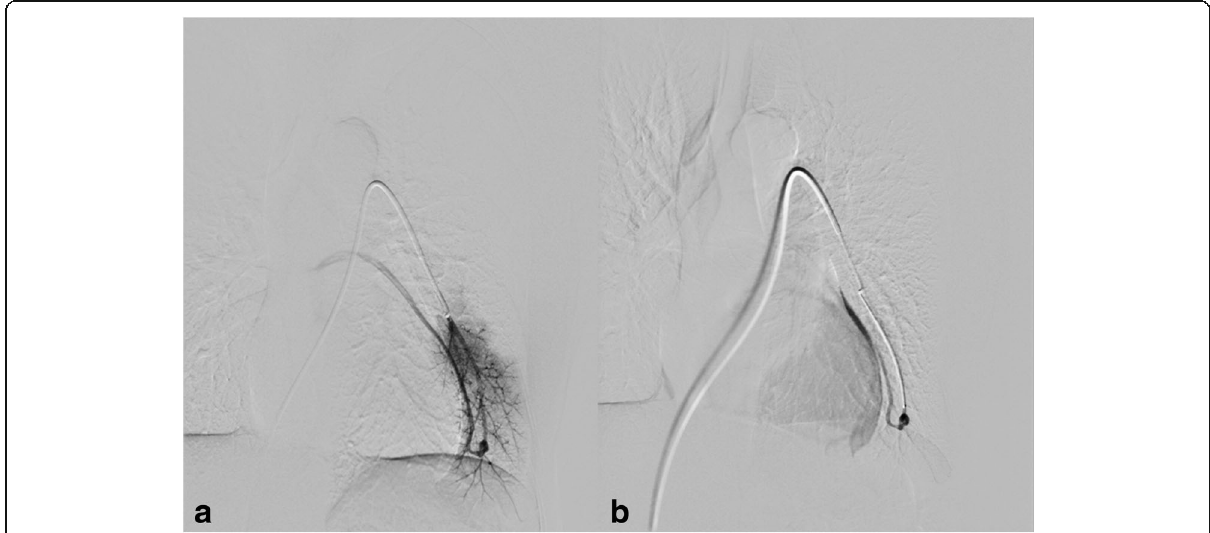
Fig. 1 a Baseline pulmonary digital subtraction angiography in a 52-year-old woman, affected by HHT, with several small PAVMs. b The biggest of these was located in the left lower lobe, with a feeding artery of 3